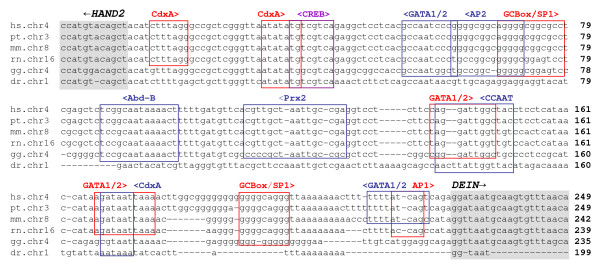
Sequence alignment of the complete nucleotide sequence of the bidirectional promoter between HAND2 and DEIN in human (hs), chimpanzee (pt), mouse (mm), rat (rn), chicken (gg) and zebrafish (dr). First exons of HAND2 and DEIN are shaded in grey. Direction of transcription is indicated by black arrows. Nucleotides are numbered relative to the first nucleotide of the bidirectional promoter. Putative Trancription Factor Binding Sites (TFBS) are boxed. The directionality of TFBS is indicated by arrowheads and color of boxes (<, blue, HAND2-orientation; >, red, DEIN-orientation). SP-1, specificity protein 1; AP-1 and AP-2, activator protein 1 and 2; CdxA, CdxA homeobox gene; Abd-B, Abdominal-B; CREB, cAMP response element-binding protein; Prx2, paired related homeobox 2.